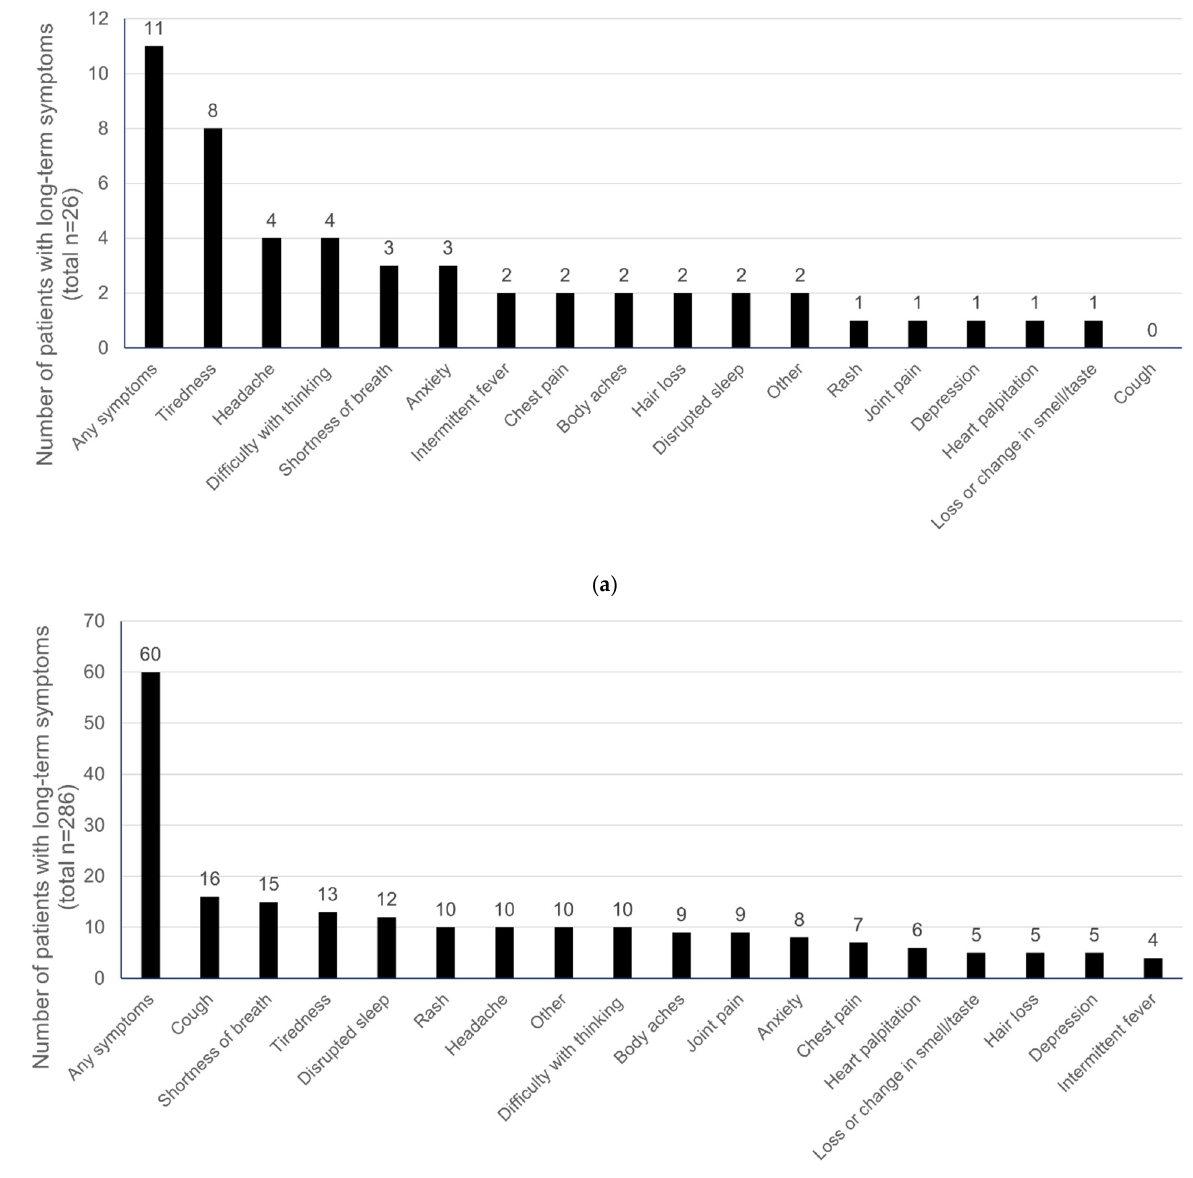
Figure 1. ( a ) Chronic long-term symptoms ( ≥ 30 days) in MIS-C children; ( b ) Chronic long-term symptoms ( ≥ 30 days) in non-MIS-C children.